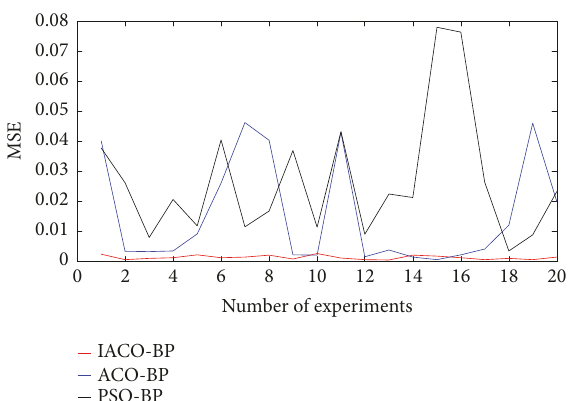
Figure 6: MSE curves of three optimizing BP algorithms.